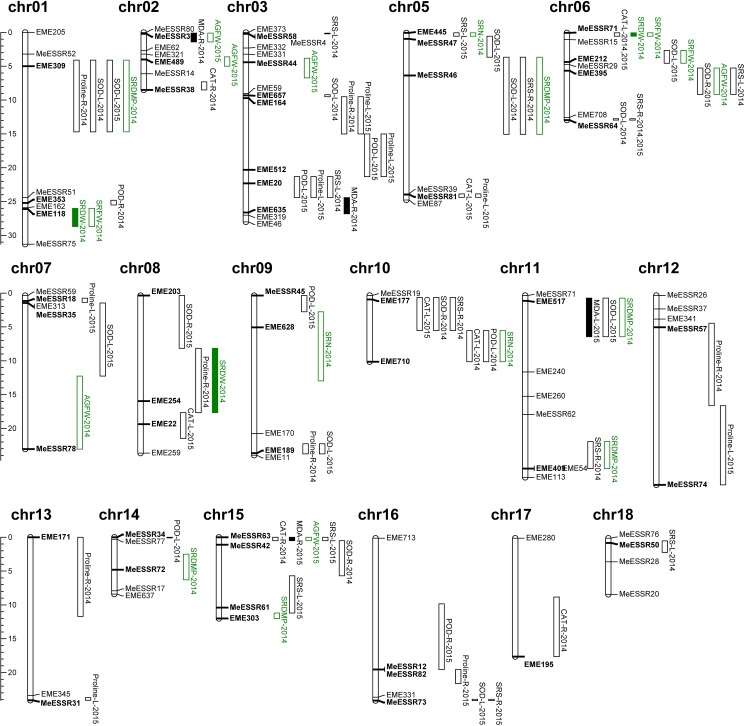
Distribution of associated markers in cassava genome (P<0.05).